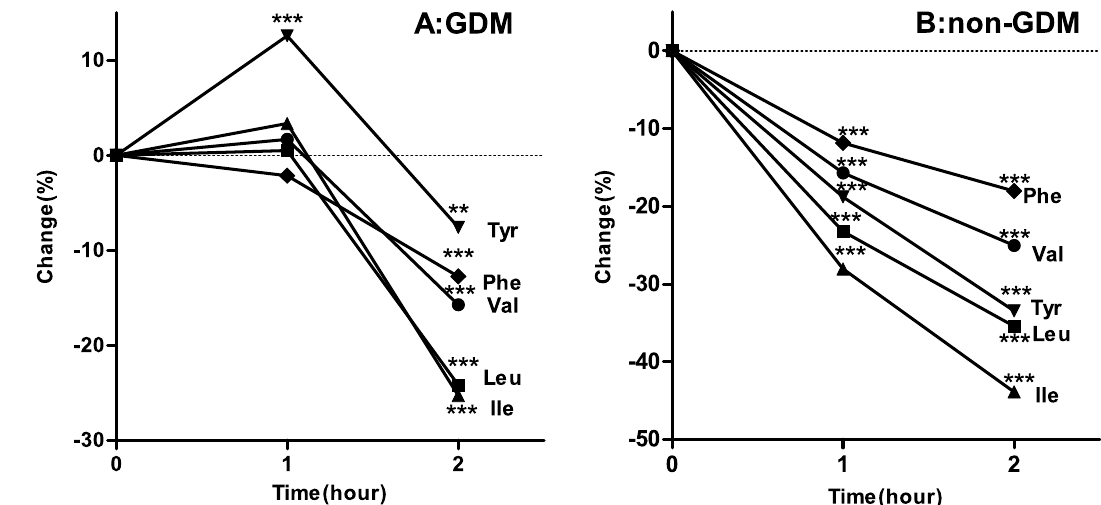
Figure 1. Amino acid changes in response to an oral glucose tolerance test. The dots denoted mean percent change. Percent change was defined as the absolute change in relative to baseline. ( A ) Women with gestational